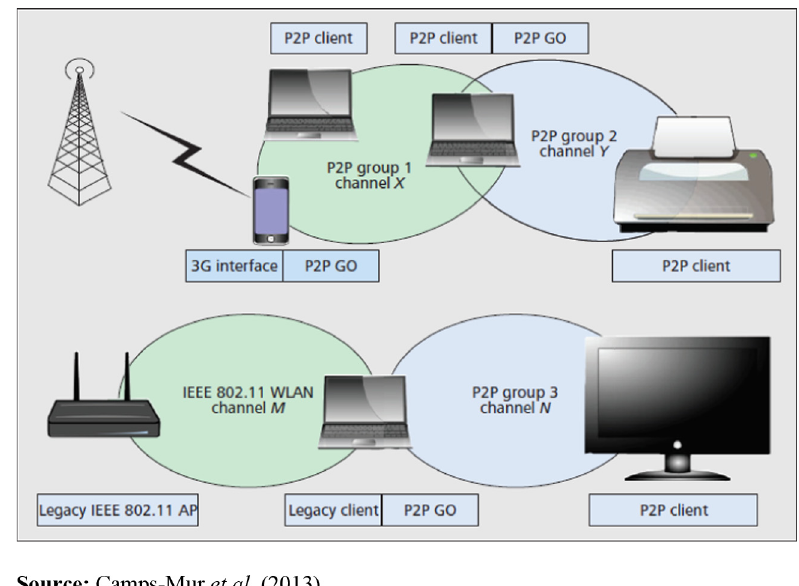
Figure 3. Example of WiFi direct